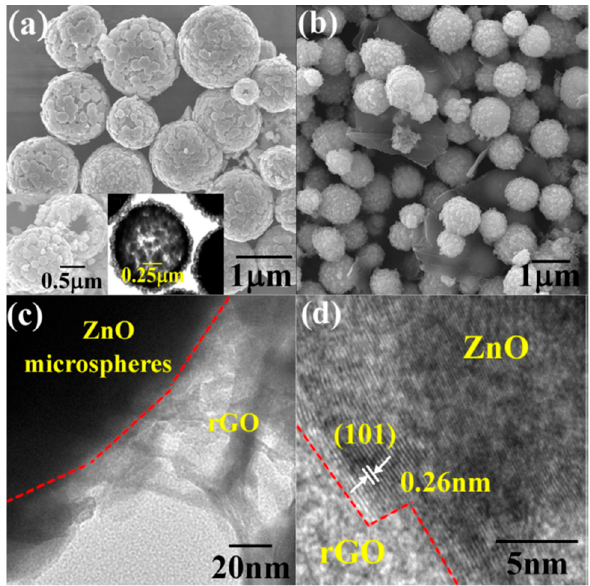
Figure 18. SEM images of ZnO ( a ) and ZrG-1 ( b ), TEM image of ZnO (inset of ( a )), TEM ( c ) and HRTEM ( d ) images of ZrG-1. Reproduced with permission from Elsevier [61].